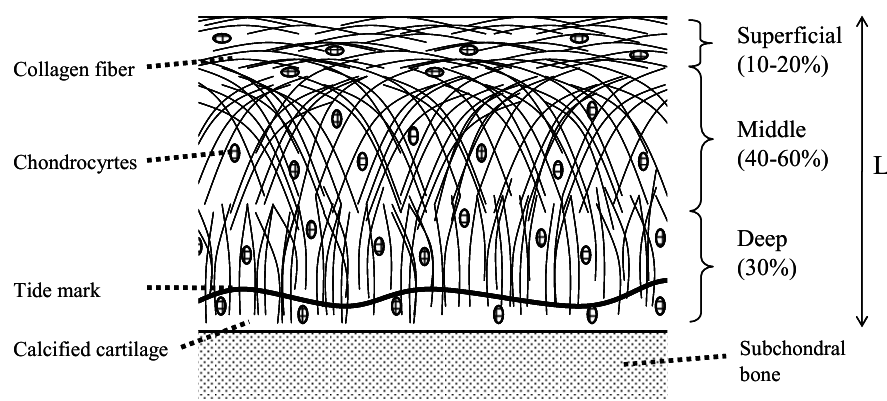
Figure 13: Schematic drawing of the layer structure of articular cartilage. In the superficial layer, collagen fibers lie primarily parallel to the cartilage surface. Fibers are randomly oriented in middle layer and perpendicular to the cartilage surface in deep layer. Thickness of the cartilage (L) is about 5 mm for humans.